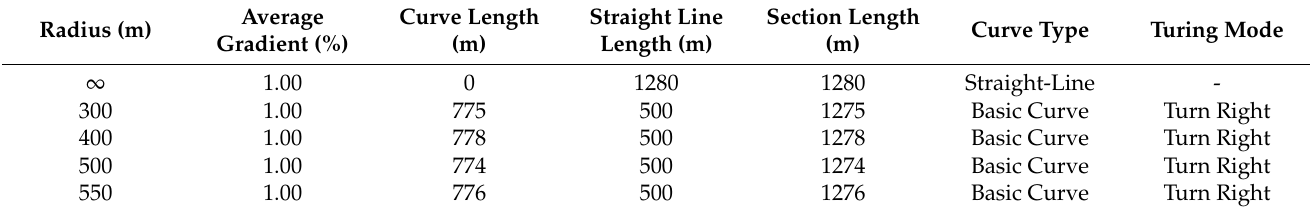
Table 1. Design index of the simulation model over a horizontal curve section.